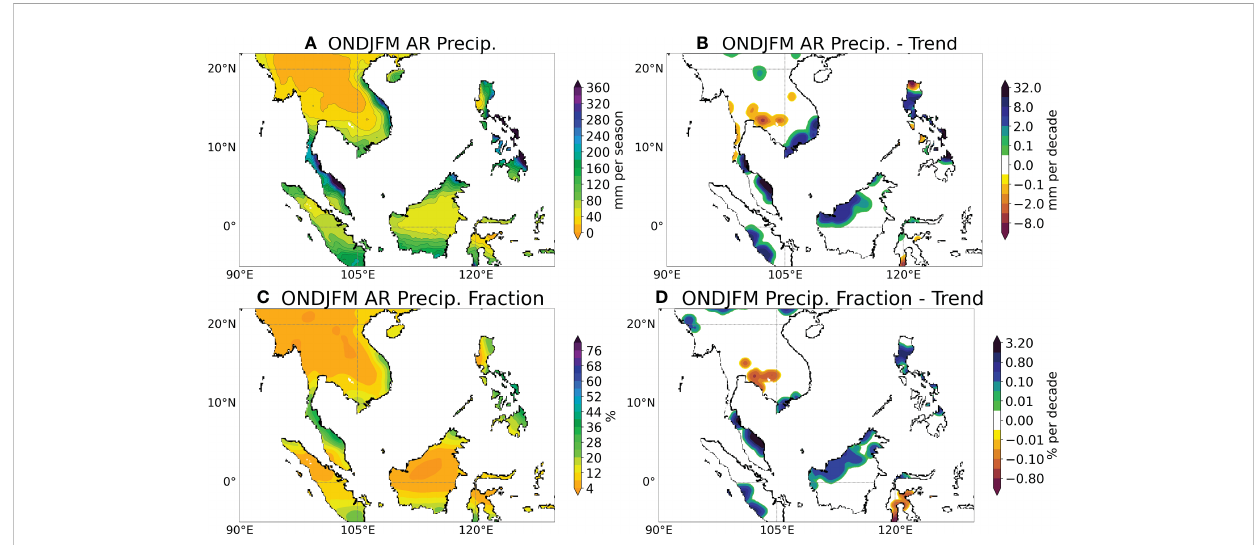
FIGURE 5 Analyses of the precipitation amount for autumn-winter seasons (ONDJFM) during the period 1951 – 2015: (A) AR-associated precipitation amount (unit: mm per year); (B) trends in AR-associated precipitation amount (mm per decade); (C) fraction (%) of the total precipitation amount contributed by ARs; (D) trends in the fraction (% per decade) of precipitation contributed by